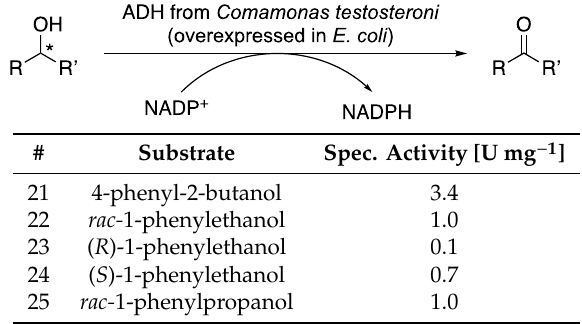
Table 2. Spectrophotometrically determined activities for the oxidation of various alcohol substrates by CtADH. The activities were obtained by use of the standard spectrophotometric assay with a substrate concentration of 10 mM in all cases. (* marks the chiral center of the product.)